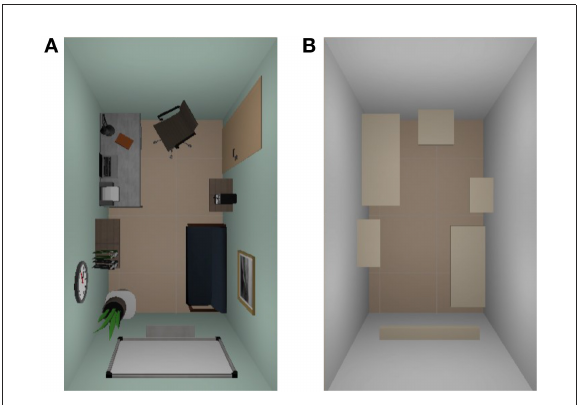
FIGURE2 The top view of one of the designed VR scenes; (A) context-rich scene, here: office; (B) empty scene matching the spatial configuration of the respective context-rich scene. The size of the rooms was set to two by three meters. Note, the scenes are shown without the end location which was represented by a column 92cm of height, and was always in the center of each room. The complete set of six implemented scenes and their respective empty equivalents can be found in Supplementary